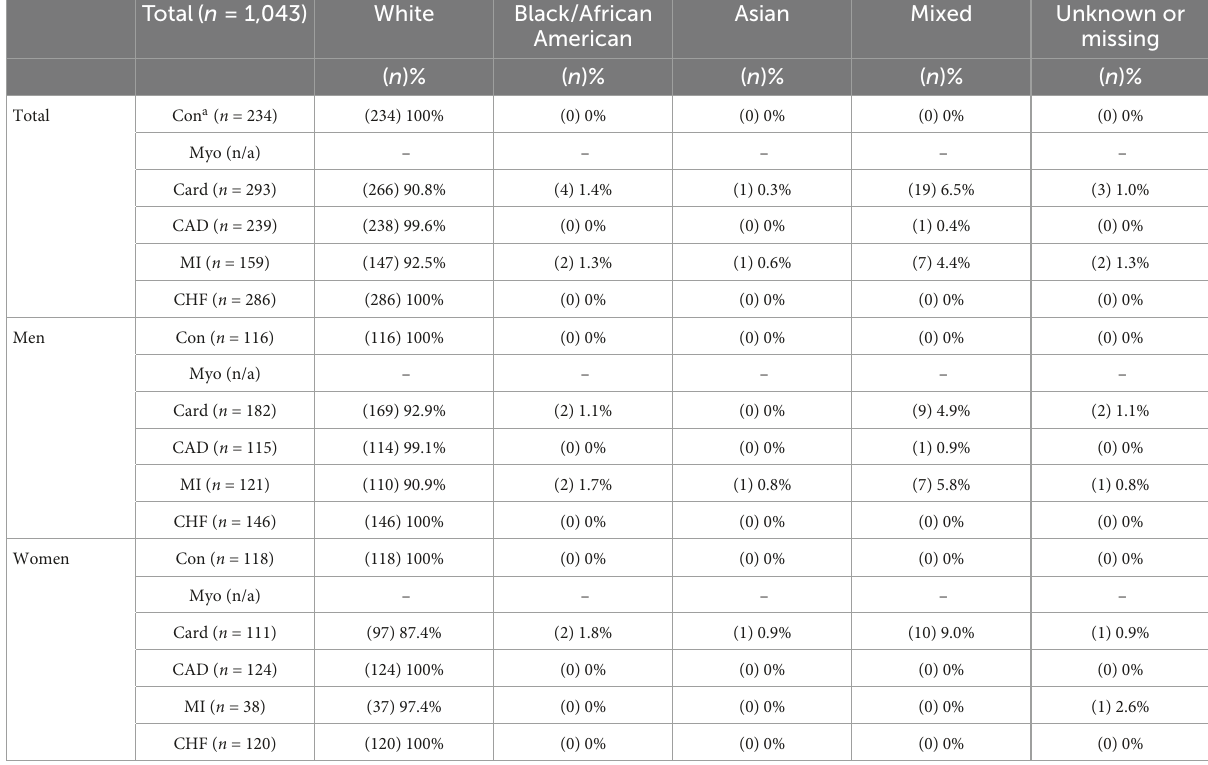
TABLE 2 Race demographics of controls and patients with CVDs according to sex ( n = 1043). Total ( n = 1,043)